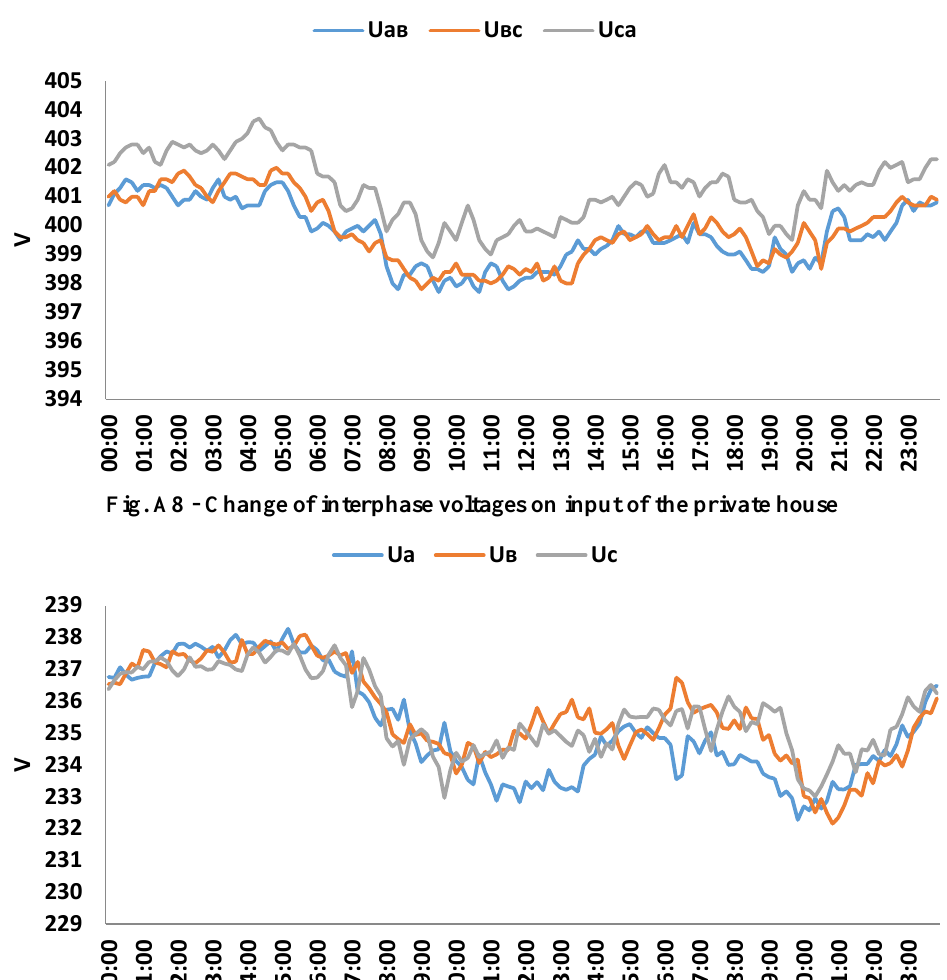
Fig. A7 - Change of the phase voltages on input of the private house